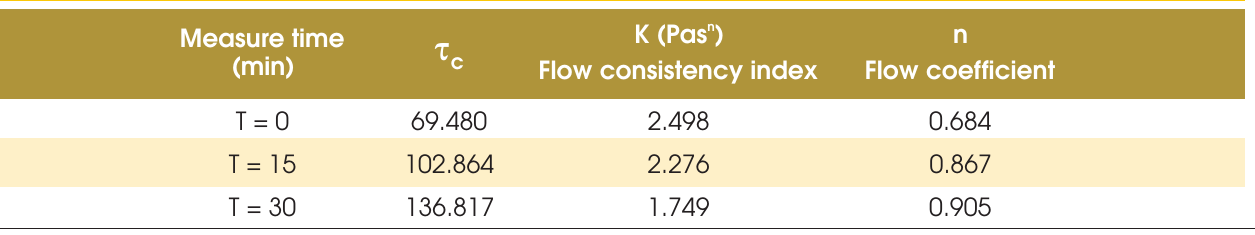
Table 16 – Rheological parameters obtained for the rheological curves of the mortar produced with CPV ARI, w/c = 0.50 and sieved sand, without superplasticizer